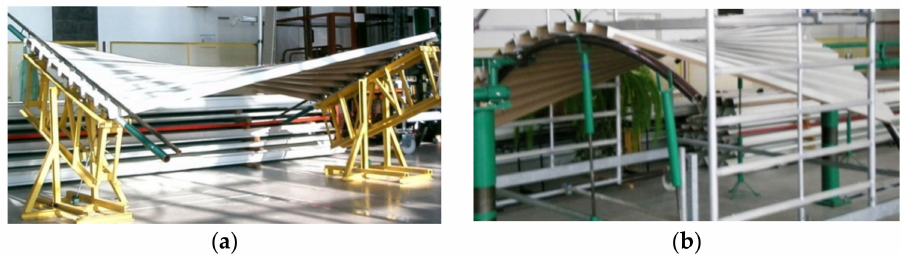
Figure 6. Experimental transformed corrugated shells supported by: ( a ) straight directrices, ( b ) curved directrices.